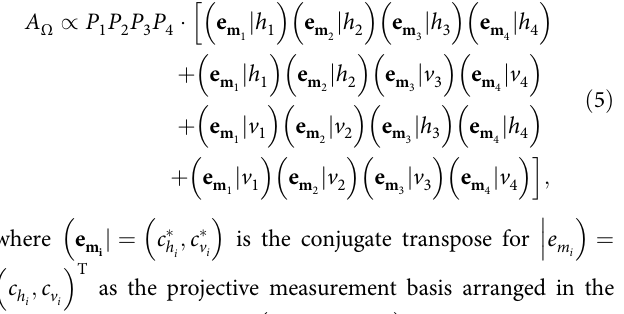
izontal (vertical) unit amplitude signal in t h e h i ( v i ) channel. Here